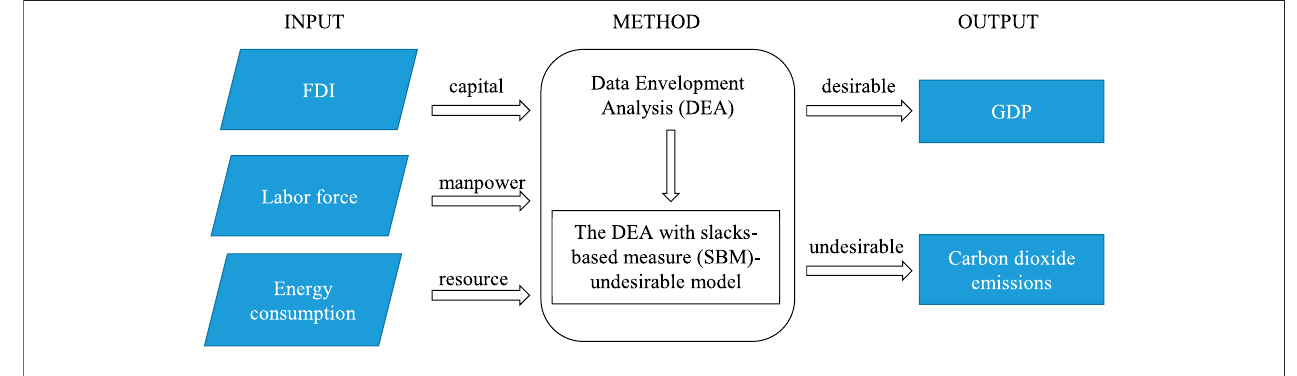
FIGURE 3 | Schematic diagram of SBM input and output.